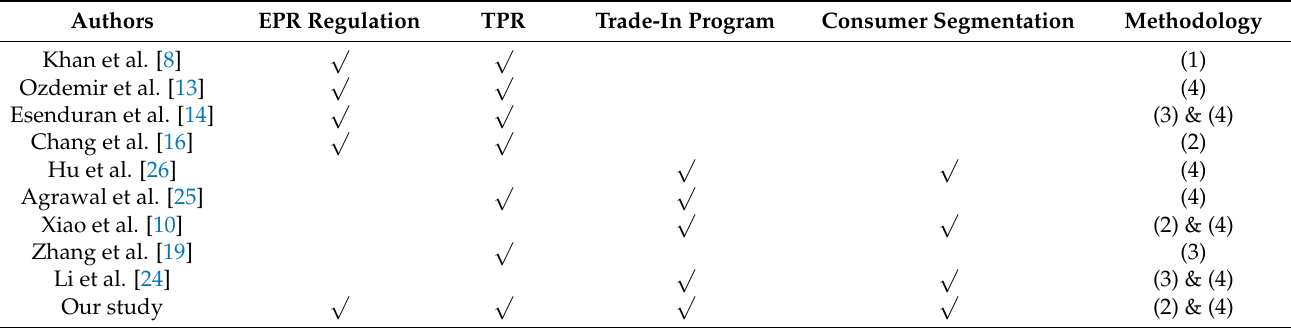
Table 1. Comparison of this study with related